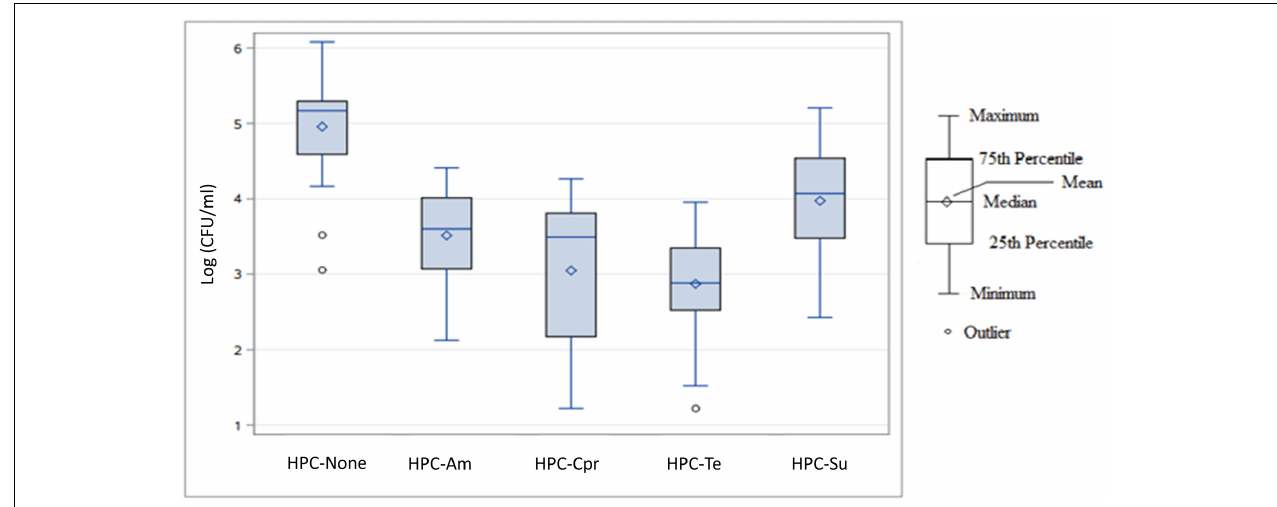
FIGURE 3 | Box plot of log-transformed concentration distributions (log 10 CFU/mL) of heterotrophic bacteria capable of growing on antibiotic amended agar by antibiotic agent across all sampling events and sampling sites. HPC-none, no antibiotic added; HPC-Am, HPC on ampicillin amended R2A plate; HPC-Cpr, HPC on ciprofloxacin amended R2A plate; HPC-Te, HPC on tetracycline amended R2A plate; HPC-Su, HPC on sulfamethoxazole amended R2A